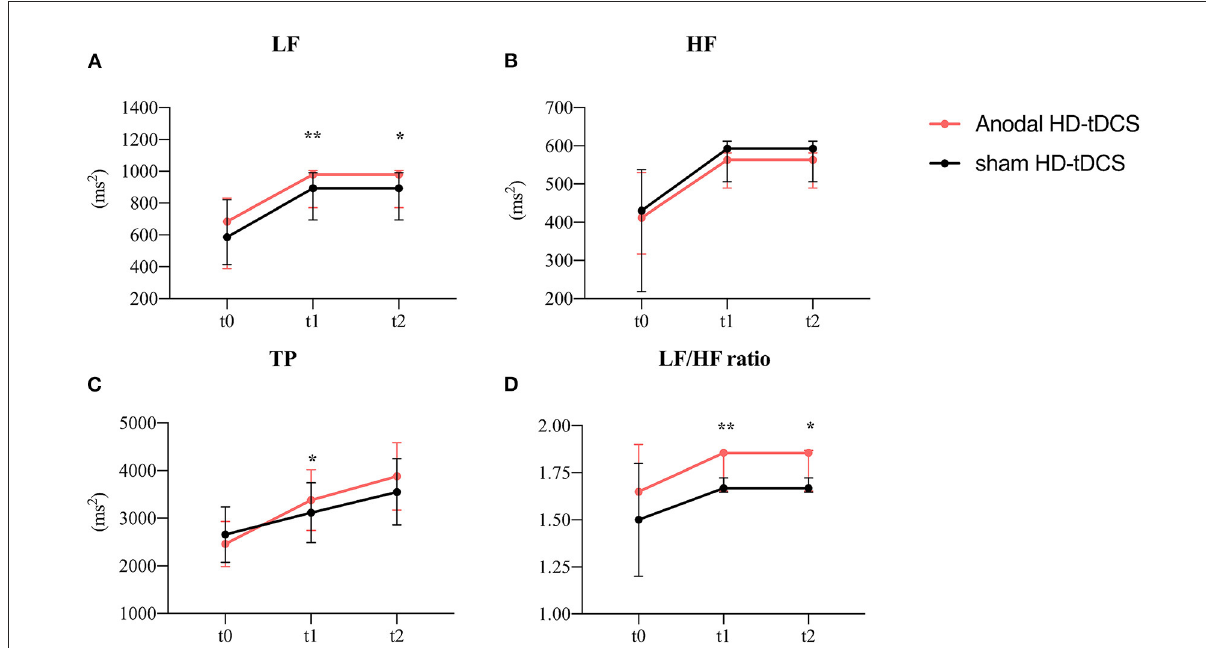
FIGURE6 Evolution of frequency-domain heart rate variability. (A) Effect of the intervention on LF. Graphs show the median values with error bars indicating the 95% confidence intervals. (B) Effect of the intervention on HF. Graphs show the median values with error bars indicating the 95% confidence intervals. (C) Effect of the intervention on TP. Graphs show the median values with error bars indicating the 95% confidence intervals. (D) Effect of the intervention on LF/HF. Graphs show the median values with error bars indicating the 95% confidence intervals. Asterisk indicates that the intervention differed at the between-group level at this time point ( p < 0.05), double asterisks at 0.01 level. The red line represents the Anodal HD-tDCS group and the black line represents the sham stimulation group.